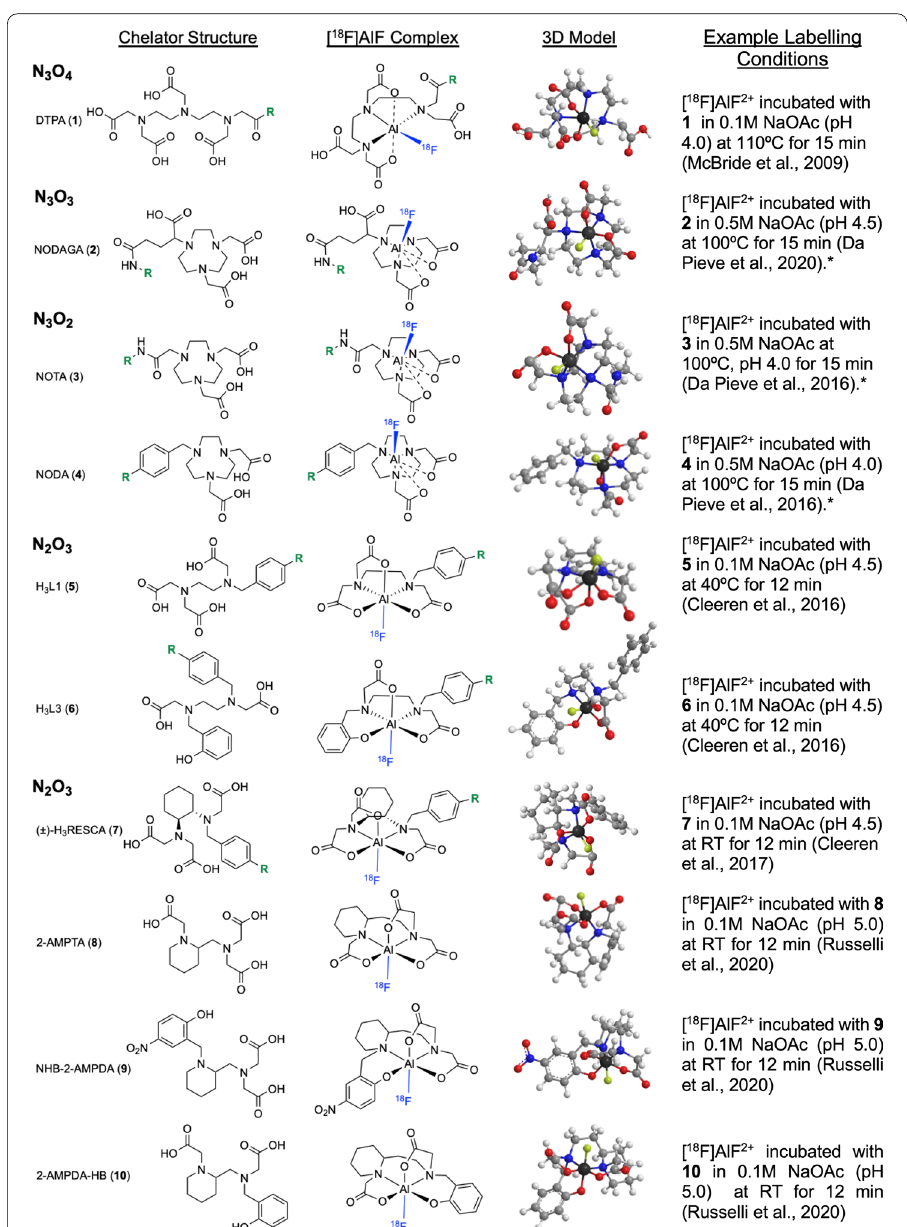
Fig. 3 Structures of chelators evaluated for [ 18 F]AlF and their proposed complexes. R bioconjugation = handle . 3D models were created in ChemBio3D (Cambridgesoft, UK) with MM2 energy minimization applied. Atom colours: carbon light grey, hydrogen white, oxygen red, nitrogen blue, fluorine yellow, = = = = = aluminium dark grey. RT room temperature. *Optional 1:1 (v/v) co-solvent included in the reaction = = mixture to improve